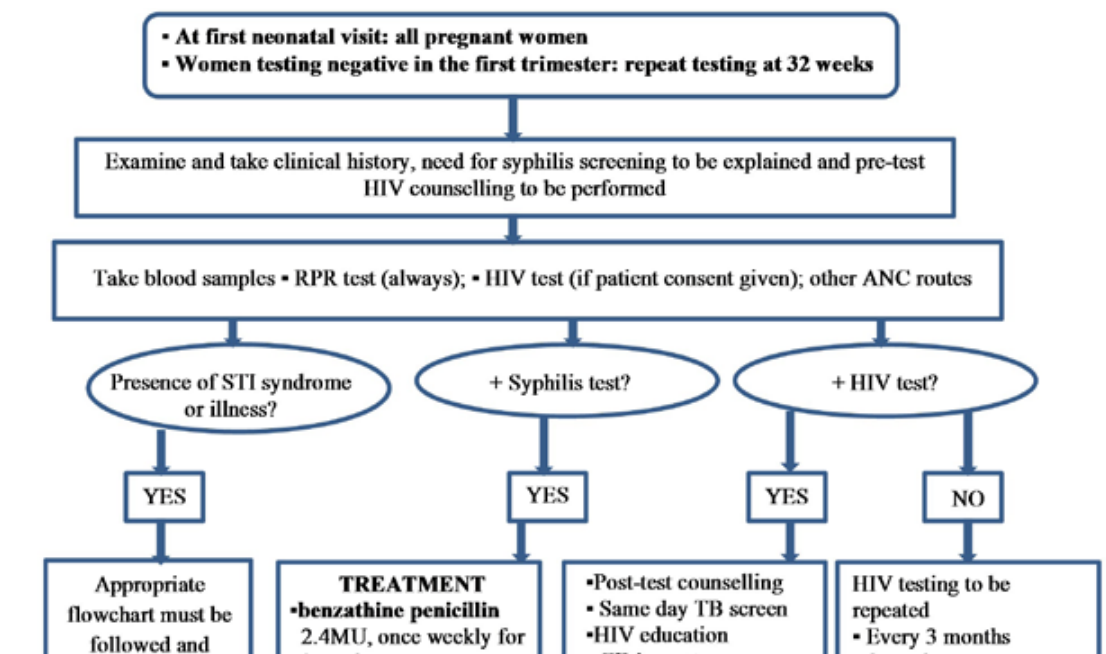
The page number in the footer is not for bibliographic referencingwww.tandfonline.com/oemd